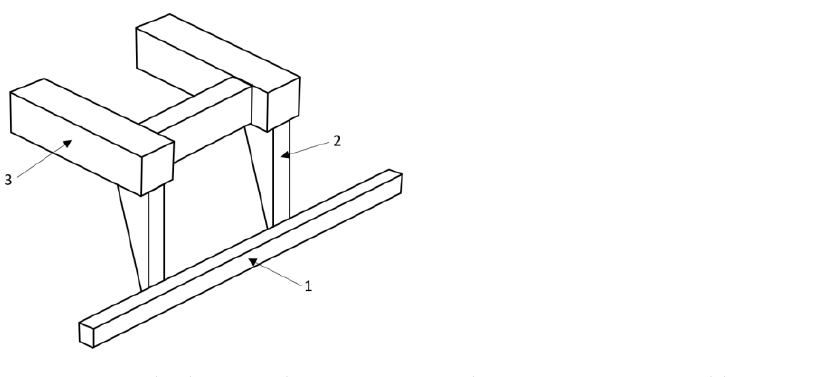
Figure 2. Standard rear underrun protective device. 1 — RUPD guard bar; 2 — Support member; 3 — Vehicle frame.